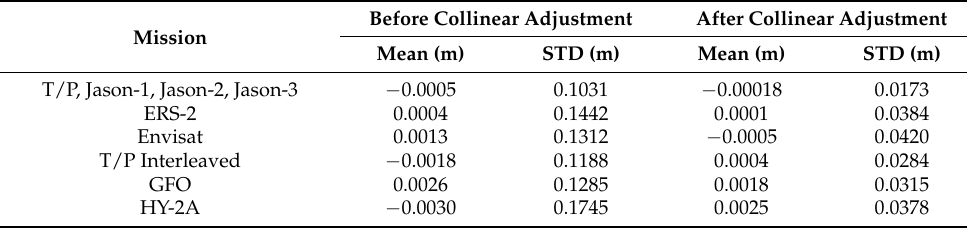
Table 2. The results of crossover differences of SSH before and after the collinear adjustment. Before Collinear Adjustment After Collinear Adjustment Mission